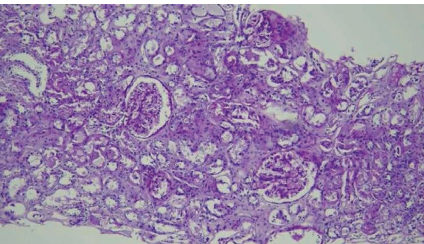
Figure 1: PAS × 100. Slight enlargement of the glomerular tangles and slight thickening of the basement membrane are observed.